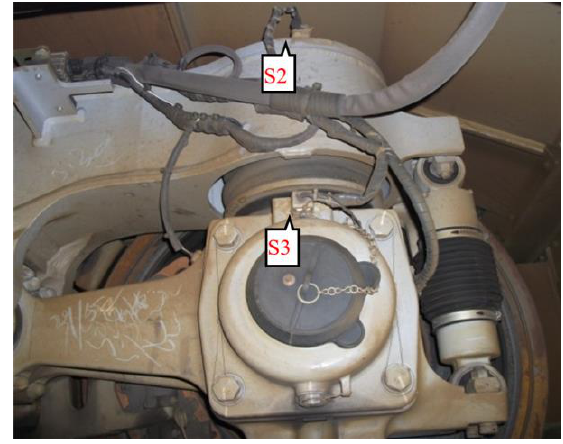
Figure 6. Site installation drawing.